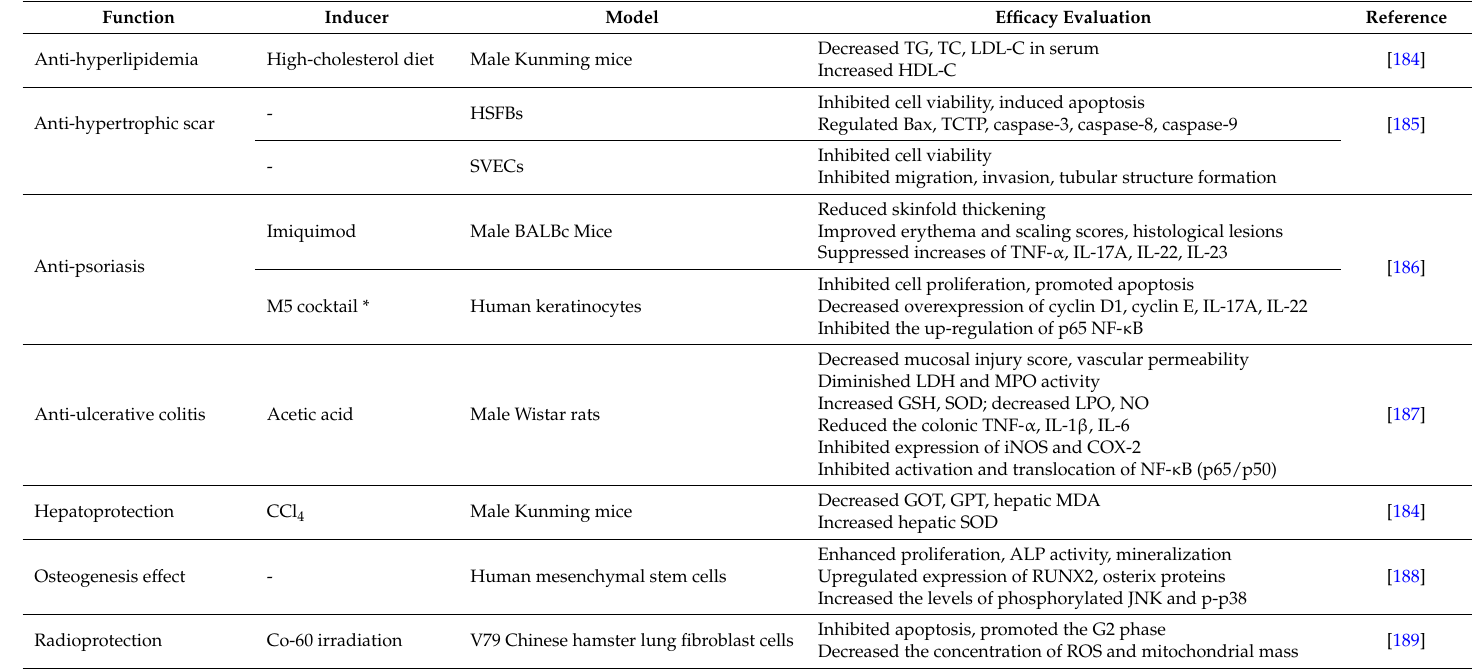
Table 4. Other pharmacological effects of